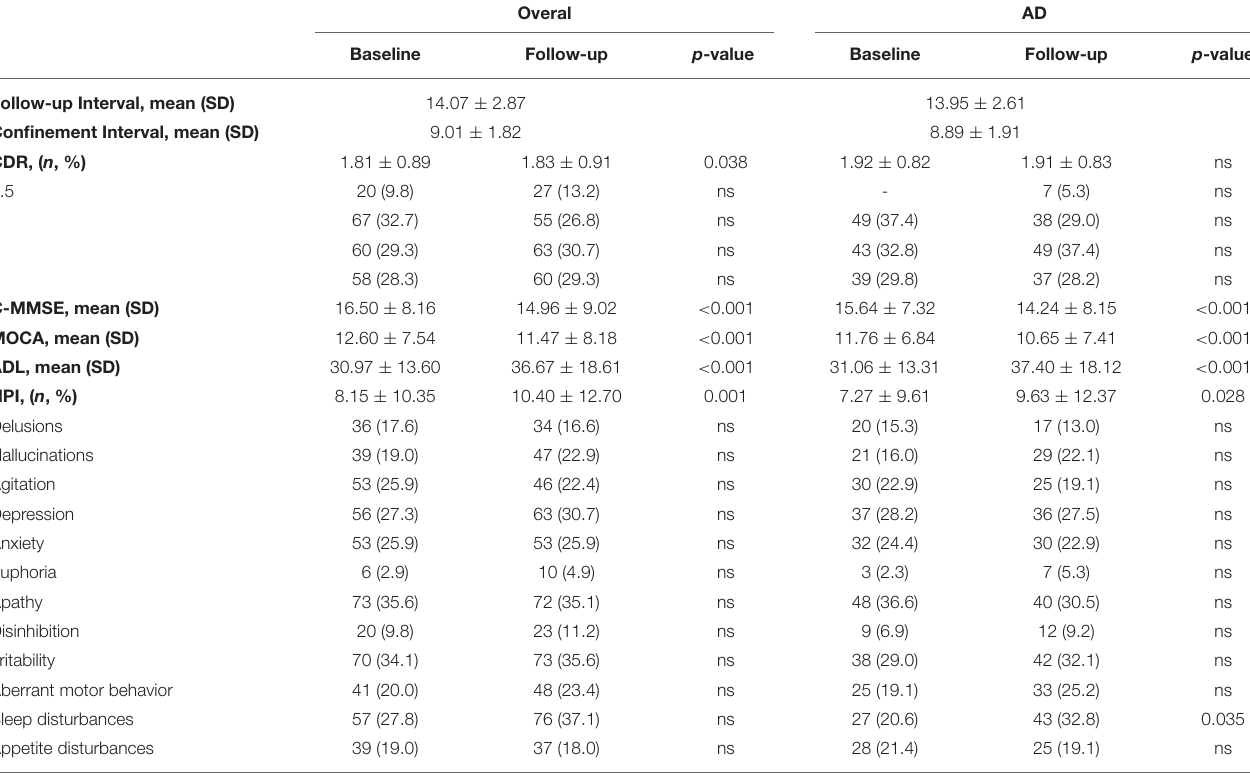
TABLE 2 | Changes in neuropsychiatric performance during COVID-19 pandemic confinement. Overal AD Baseline Follow-up p -value Baseline Follow-up p